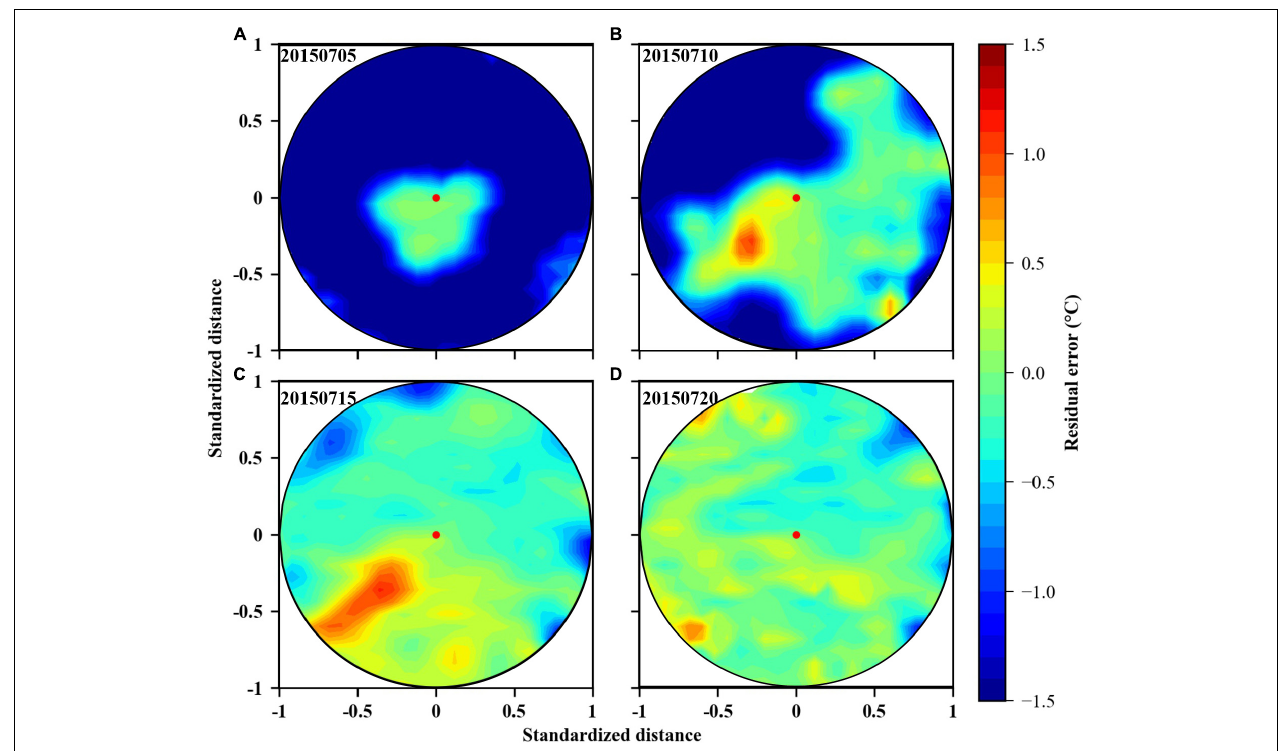
FIGURE 7 | (A–D) Show the distribution of the residual errors inside the standard circle from July 5 to July 20, 2015.